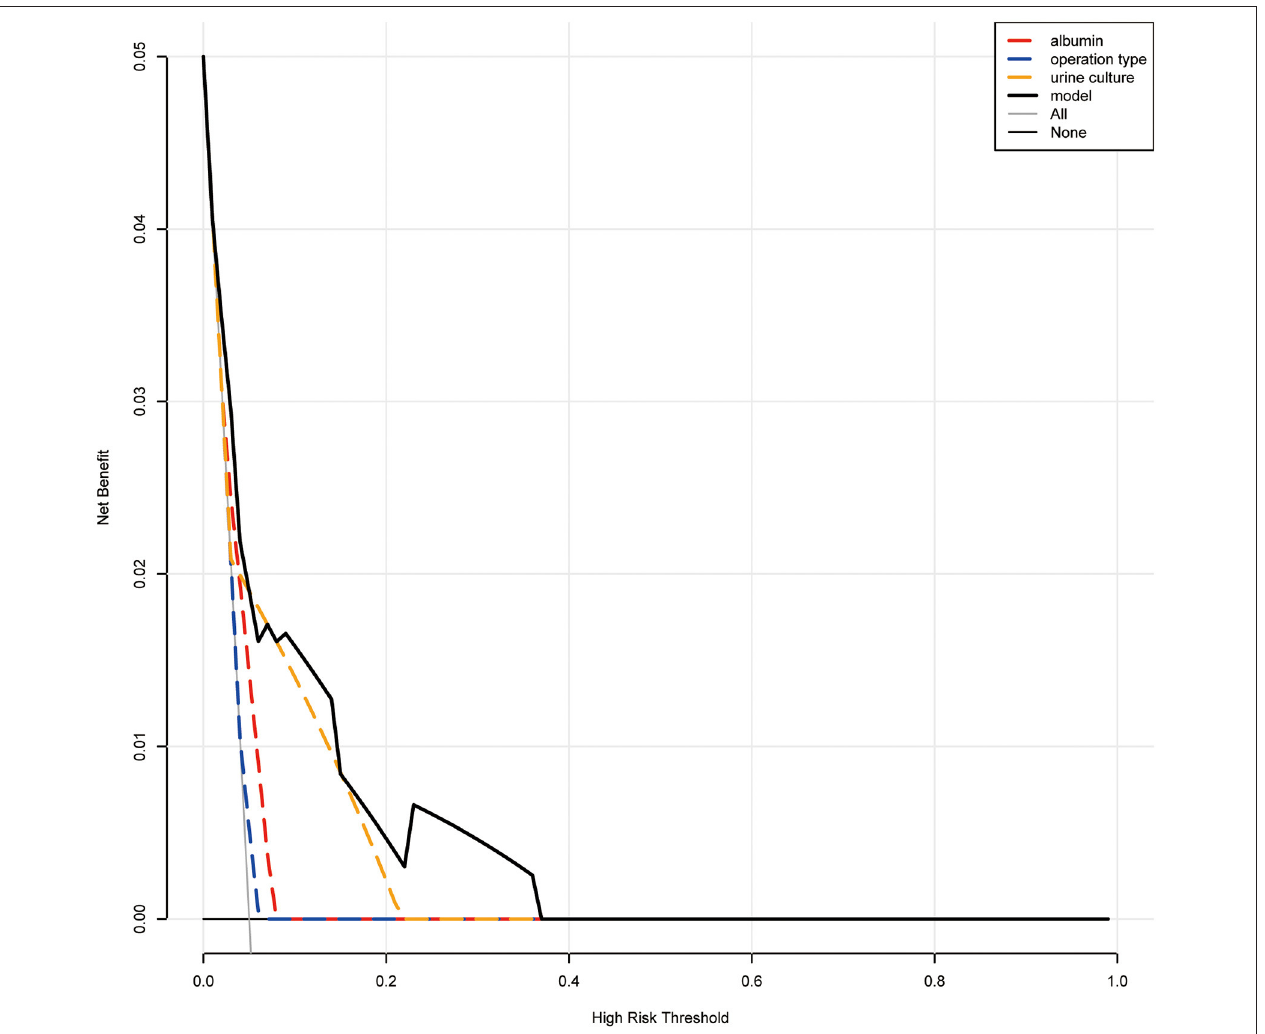
FIGURE 5 | Decision curve analysis (DCA). When the risk threshold is around 10–38%, the net benefit of application of the model on taking measures is greater than the “treat-all-patient” or “treat-none” scheme. In addition, utilization of albumin, urine culture, or operation type alone is inferior to the model.